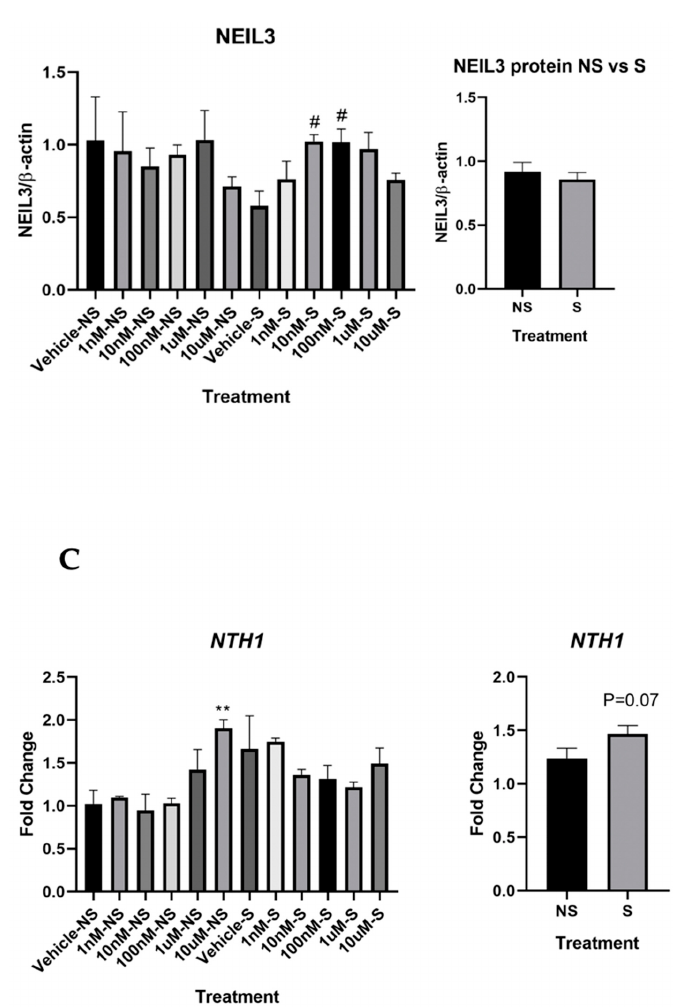
Figure 3. E ff ects of lycopene treatment at 1 nM, 10 nM, 100 nM, 1 µ M, and 10 µ M for 24 h on base excision repair-related genes. Graphic representation of fold changes in: ( A , B ) protein levels of 8-oxoguanine DNA glycosylase (OGG1), Nei-like glycosylase (NEIL)1, NEIL2 and NEIL3; and ( C ) mRNA level of NTH1. Three replicates were used for statistical analysis. Values are means ± SEMs. NS—cells not exposed to smoke; S—cells exposed to smoke; * indicates significance at p < 0.05; ** indicates significance at p < 0.01 compared with the cells not exposed to smoke treated with vehicle; # indicates significance at p < 0.05 compared with the cells exposed to smoke treated with vehicle.